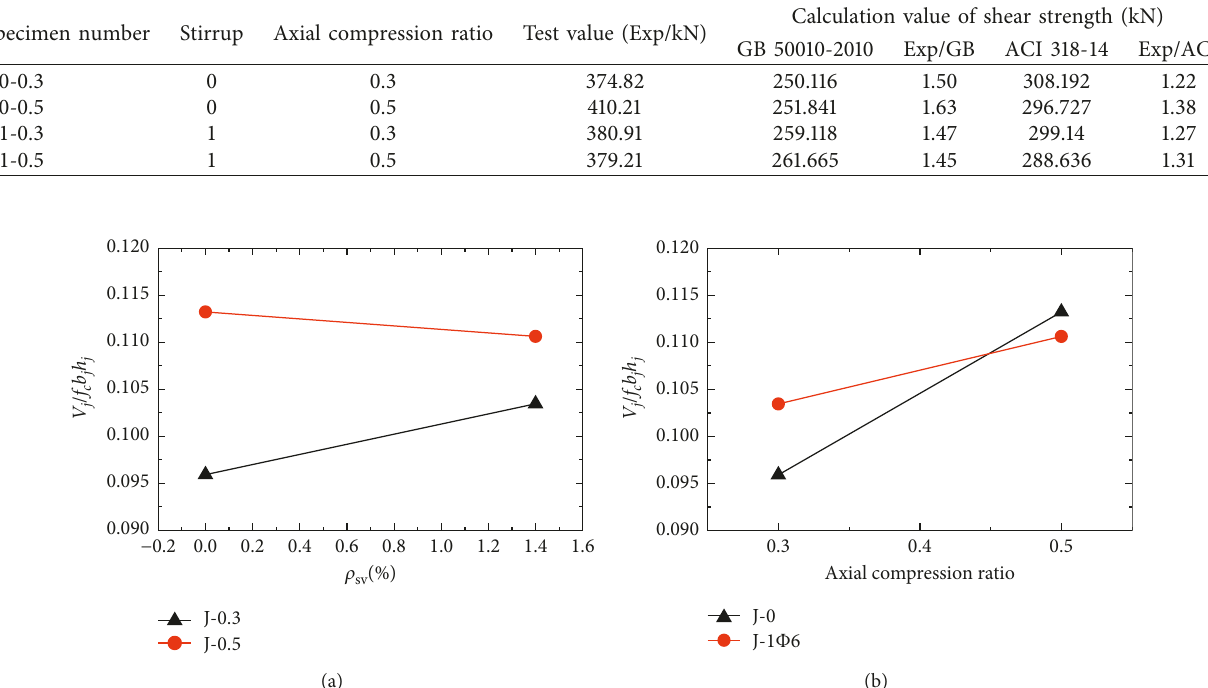
Table 6: Test results and analysis.